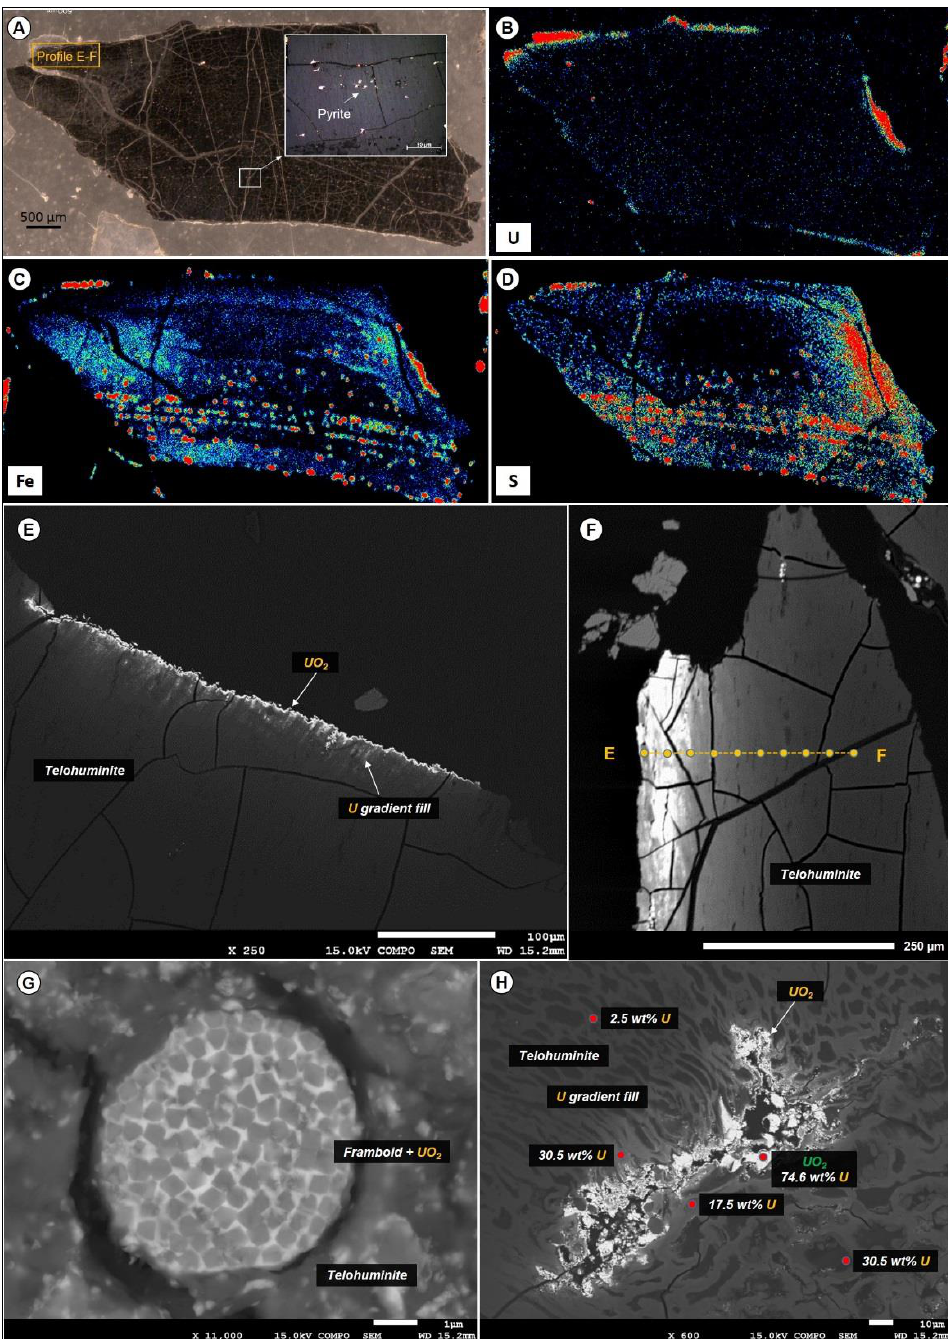
Figure 10. Telohuminite particle and the associated X-Ray microfluorescence maps. ( A ) Overview of the particle under reflected light, showing the EPMA profile position E-F for U, Fe, S and Ti, respectively, and a zoomed image showing the presence of pyrite. ( B – D ) The XRF maps for U, Fe and S. Uranium is highly concentrated around the rims and is much less abundant towards the interior of the particle. ( E ) BSE image showing uranium oxide precipitate (in this case UO 2 ) at the rim of a telohuminite particle. ( F ) The same association in higher magnification, coupled with an EPMA measurements profile (E-F/10 points), from the rim to the interior of the particle. ( G ) Uranium cement inside framboidal pyrite. ( H ) Uraninite precipitation along a fracture in the internal part of a telovitrinite/telohuminite particle. Uranium concentration decreases progressively from 74.6 to 2.5 wt % as a function of increasing distance from the fracture.